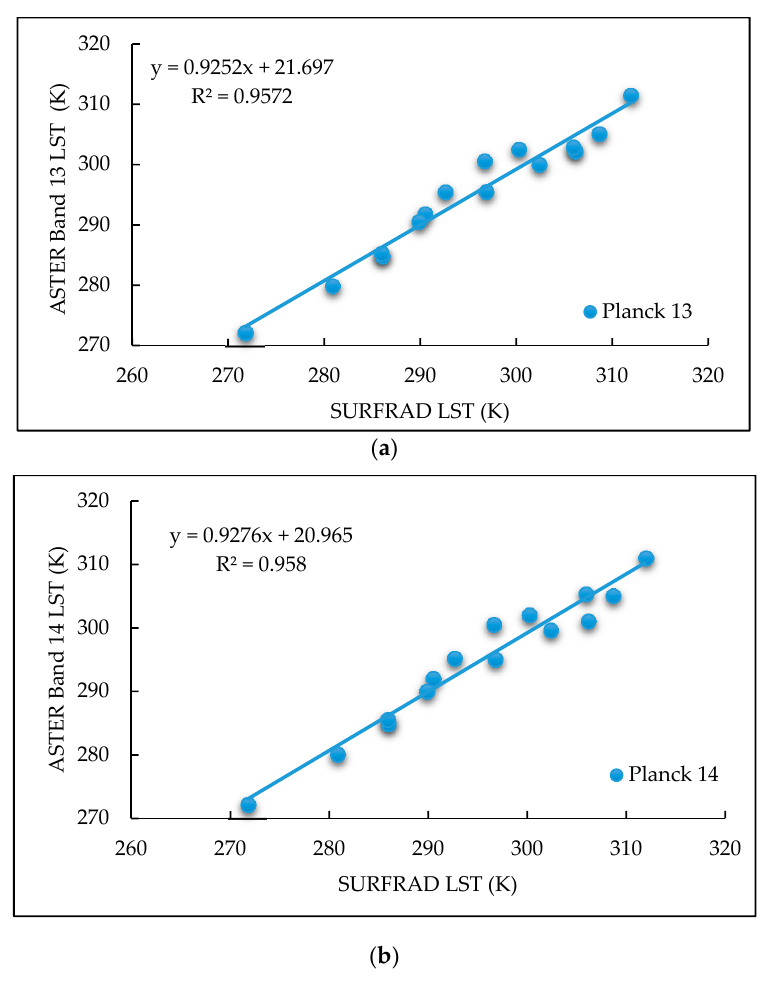
Figure 2. Comparison of scatter plots of LST inverted from ASTER data and LST derived from SURFRAD station at four SURFRAD stations: ( a ) scatter plot for LST values derived from ASTER band 13 using the Planck function and the LSTs derived from SURFRAD measurements; and ( b ) scatter plot for LST values derived from ASTER band 14 using the Planck function and the LSTs derived from SURFRAD measurements.